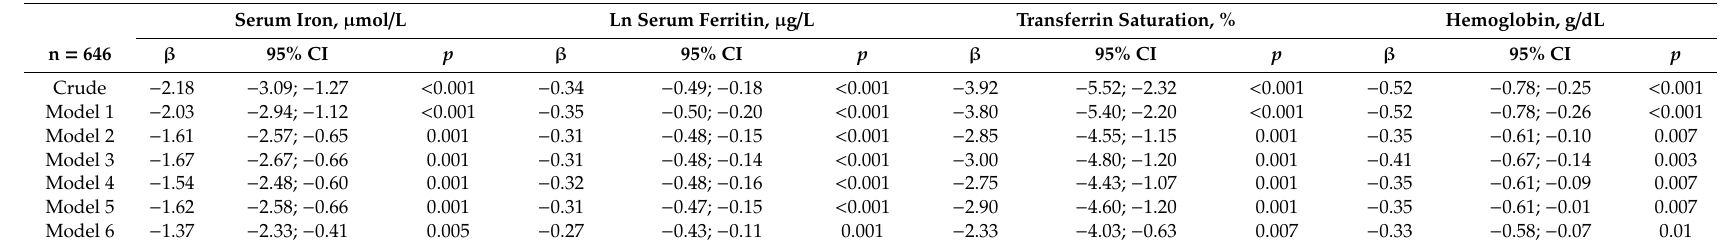
Table 2. Association of PPI use with iron status parameters in 646 stable renal transplant